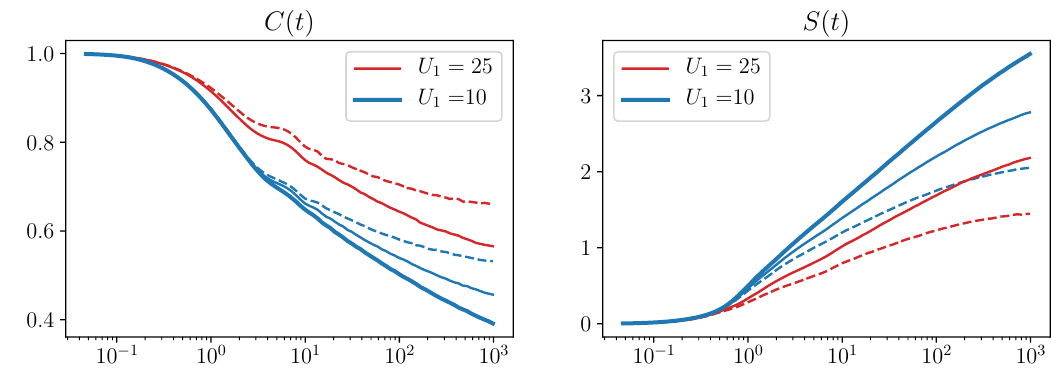
Figure 16: Time evolution of the correlation function, C ( t ) (left) and of the en- tanglement entropy, S ( t ) after a quench for W = 8 and two values of U system initially prepared in a random Fock state. The dashed, narrow and broad line correspond to system size K = 16,18,20 respectively. Observe that large U slower entropy growth and slower decay of the correlation function, in both cases the dependence on the system size remains significant.